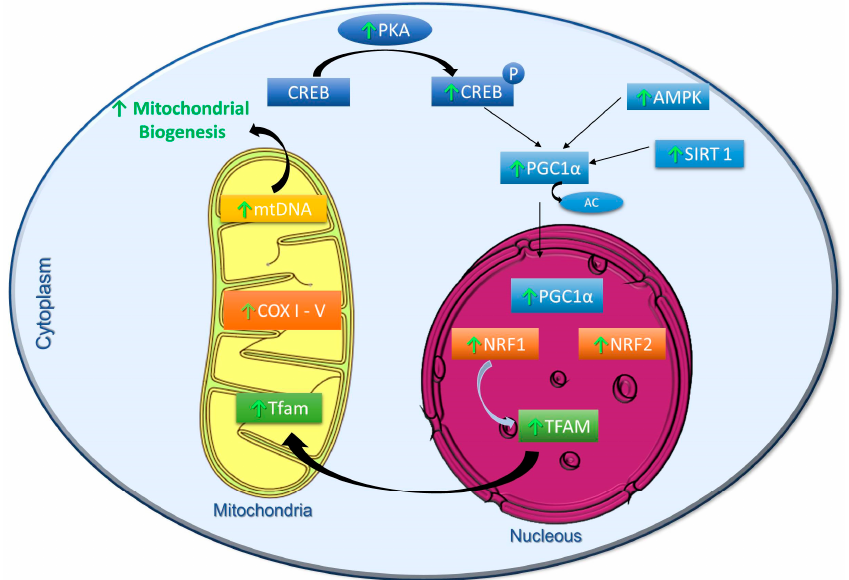
Figure 1. Schematic representation of metabolic pathways stimulated by polyphenols to activate mitochondrial biogenesis. PKA—Protein Kinase A; CREB—cyclic AMP response element binding protein; PGC1 α —peroxisome proliferator-activated receptor gamma coactivator 1 α ; AMPK—AMP protein kinase; SIRT1—Sirtuin 1; NRF1/2—nuclear respiratory factors 1 and 2; mtDNA—Mitochondrial DNA; OXPHOS I-V—Oxidative phosphorylation complexes I to V; TFAM—Mitochondrial transcription factor A; P—Phosphorylation; AC—Acetylation; ↑ —Polyphenol